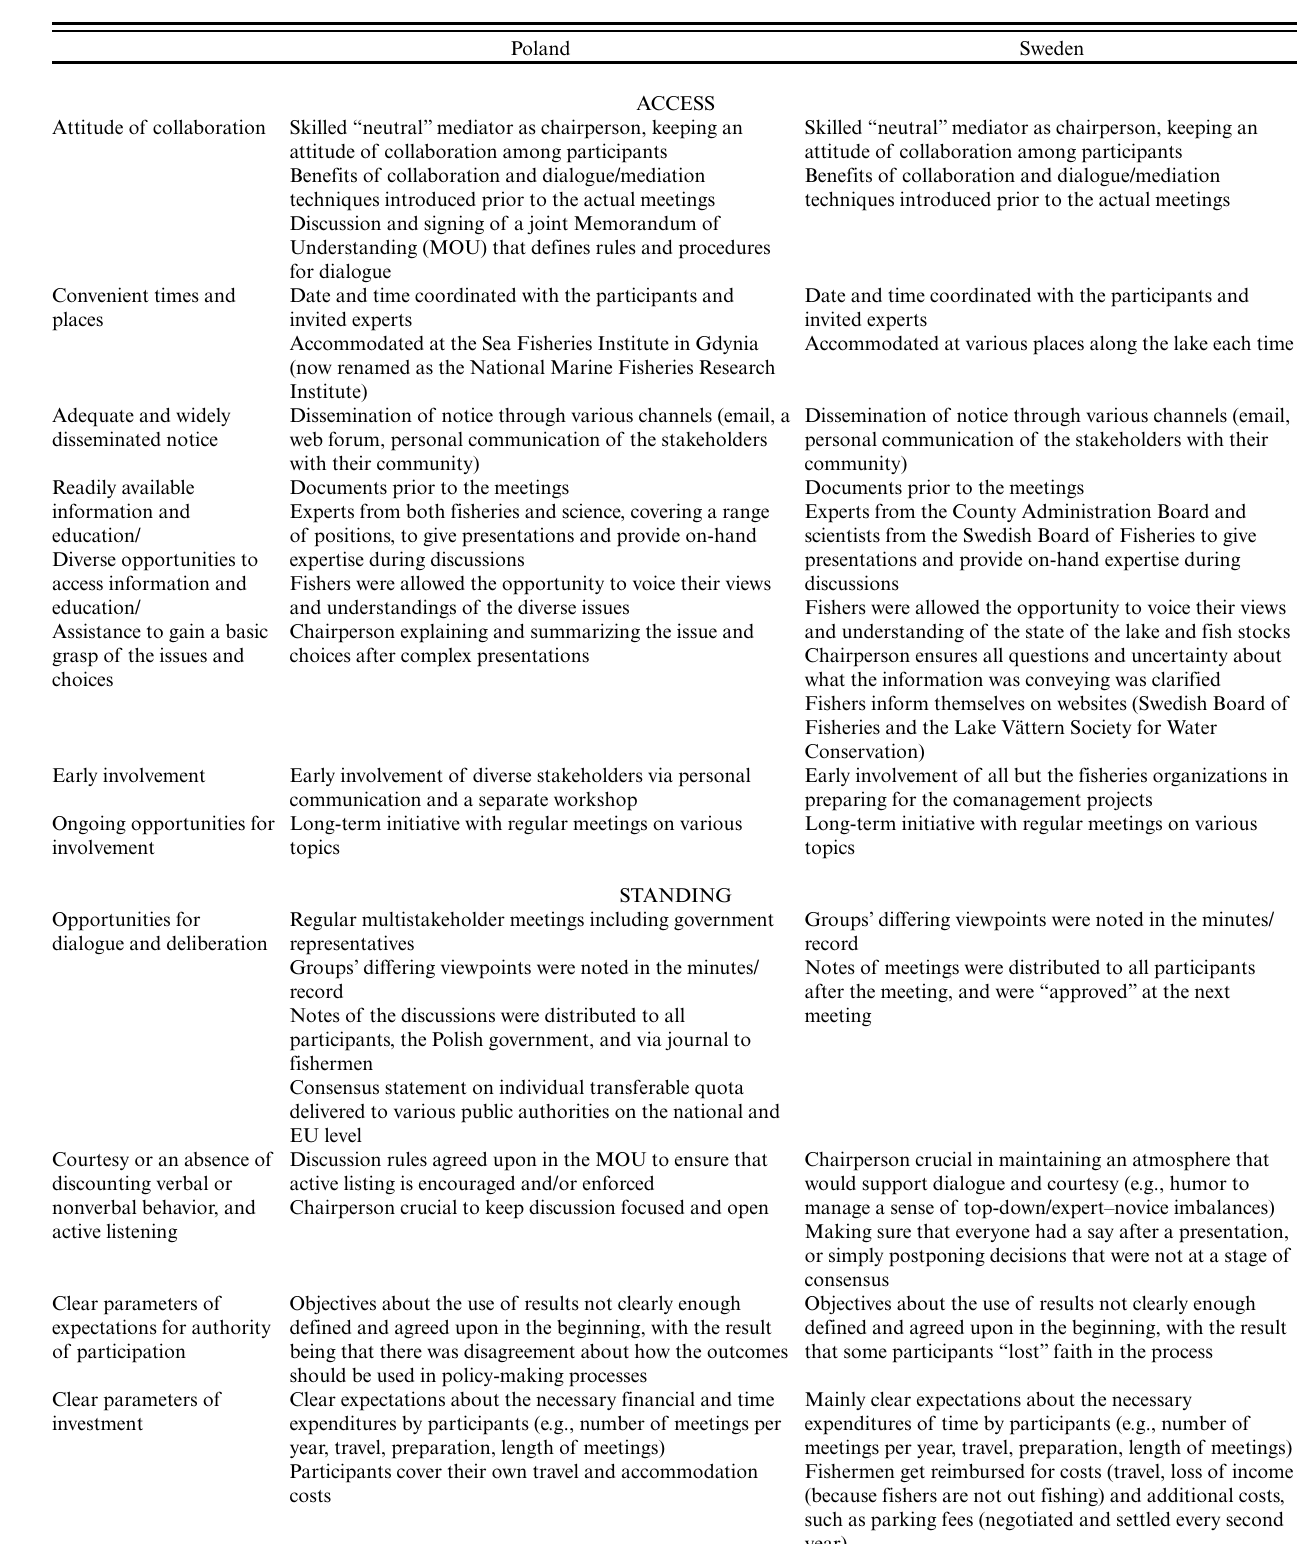
Table 2 . Process of the Swedish Co-management Initiative and the Polish Fisheries Roundtable according to the Trinity of Voice (Senecah